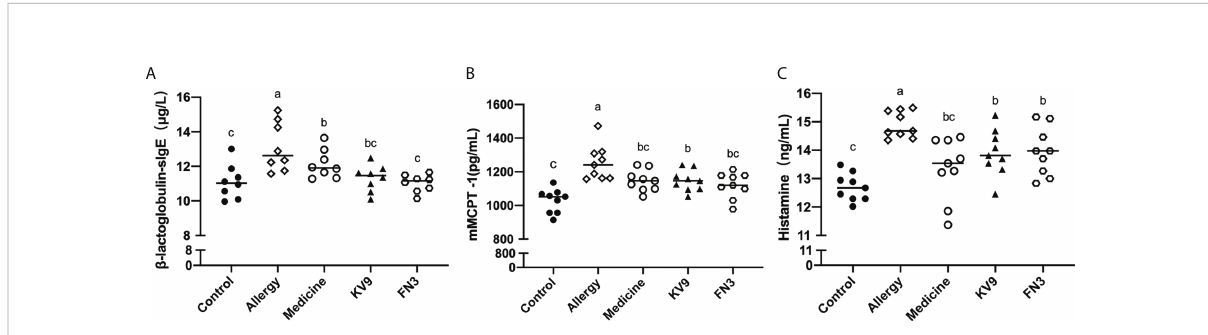
FIGURE 4 b -LG-sIgE (A) in the serum of mice. mMCPT-1 (B) in the serum of mice. Histamine (C) in the serum of mice. Identical lowercase in the fi gure indicates the lack of signi fi cance ( p < 0.05).